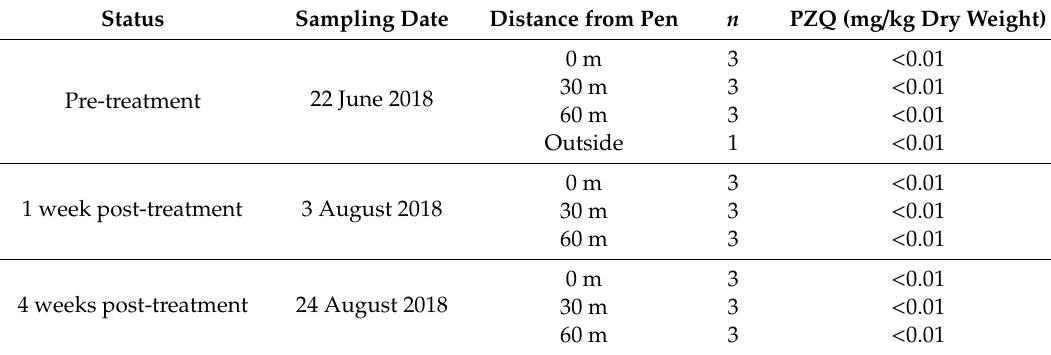
Table 2. Detection of PZQ in